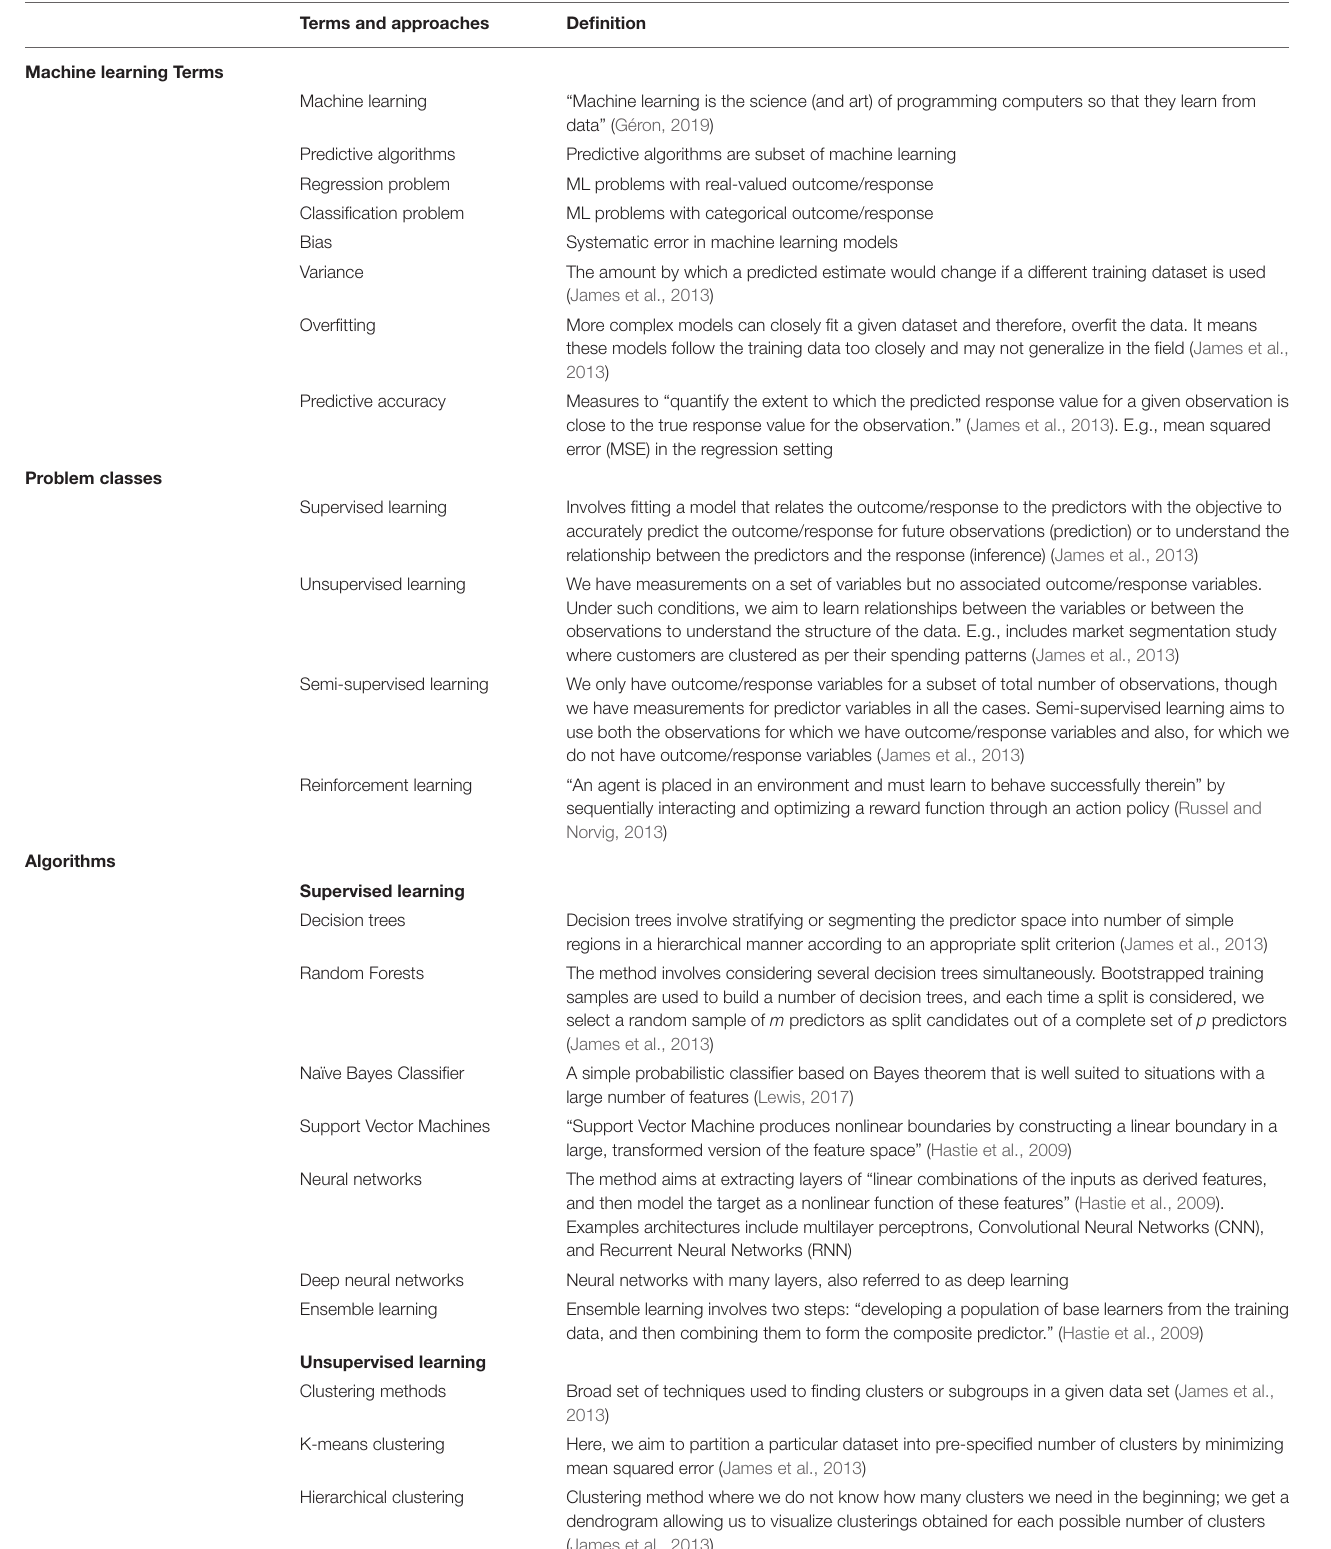
TABLE 1 | Terms and approaches in machine learning (definitions and references) *